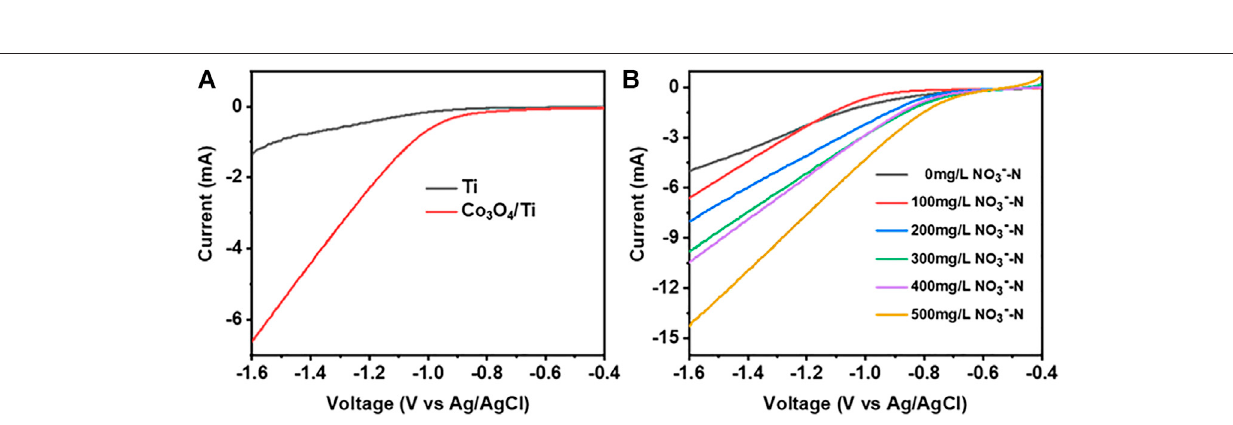
Frontiers in Chemistry |